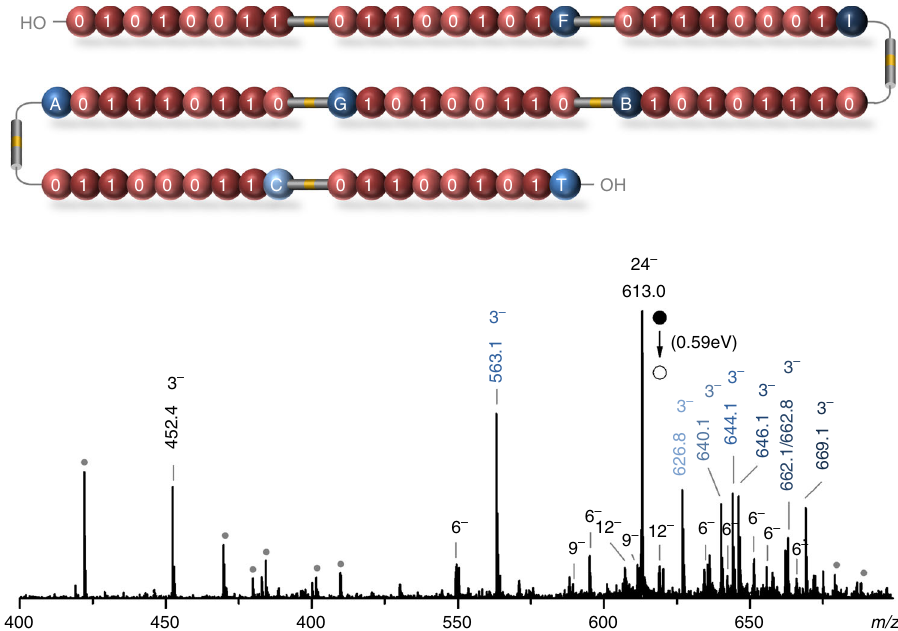
Fig. 3 MS 2 spectrum of an 8-byte digital polymer containing the ASCII-encoded word Sequence. This spectrum (0.59 eV, center of mass frame) was obtained by collision-induced dissociation of the [M-24H] 24 − precursor ion of polymer 11 in Supplementary Table 1. In this case, the MS/MS single-byte, double-byte, triple-byte, and tetra-byte fragments are predominantly observed as trianions, hexa-anions, nona-anions, and dodeca-anions, respectively. Other charge states can be observed to a minor extent and are denoted by dark grey circles (see Supplementary Figs. 21b and 22 for a detailed interpretation of each peak). The subsequent pseudo-MS 3 sequencing of all bytes is shown in Supplementary Figs. 23 –